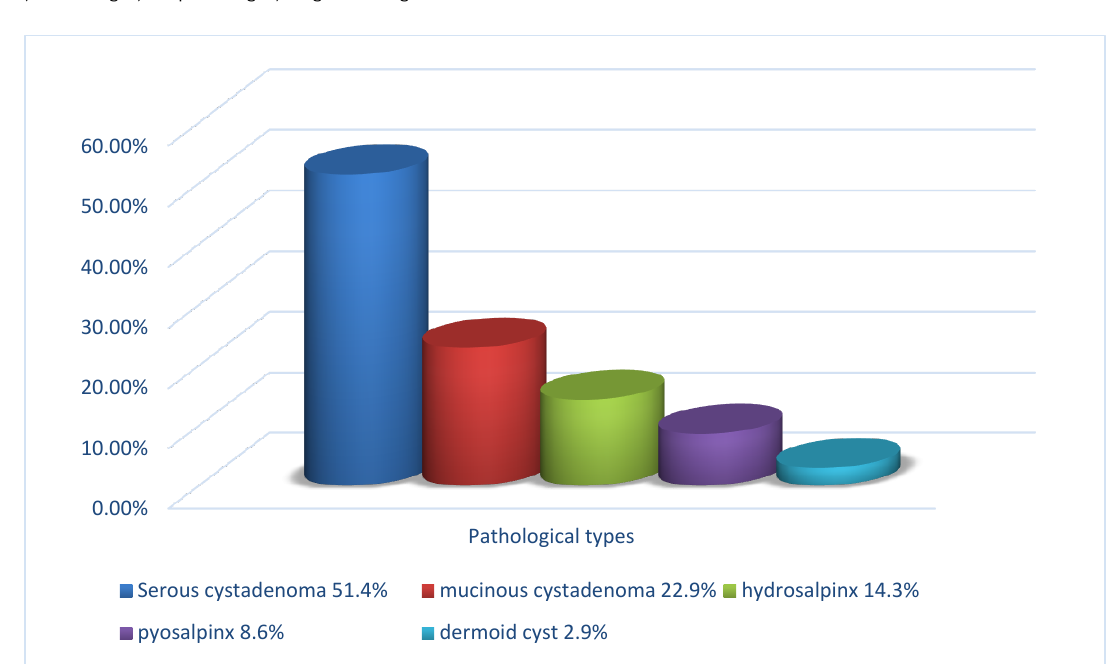
Fig. 3. The histopathological details of adnexal masses-types and